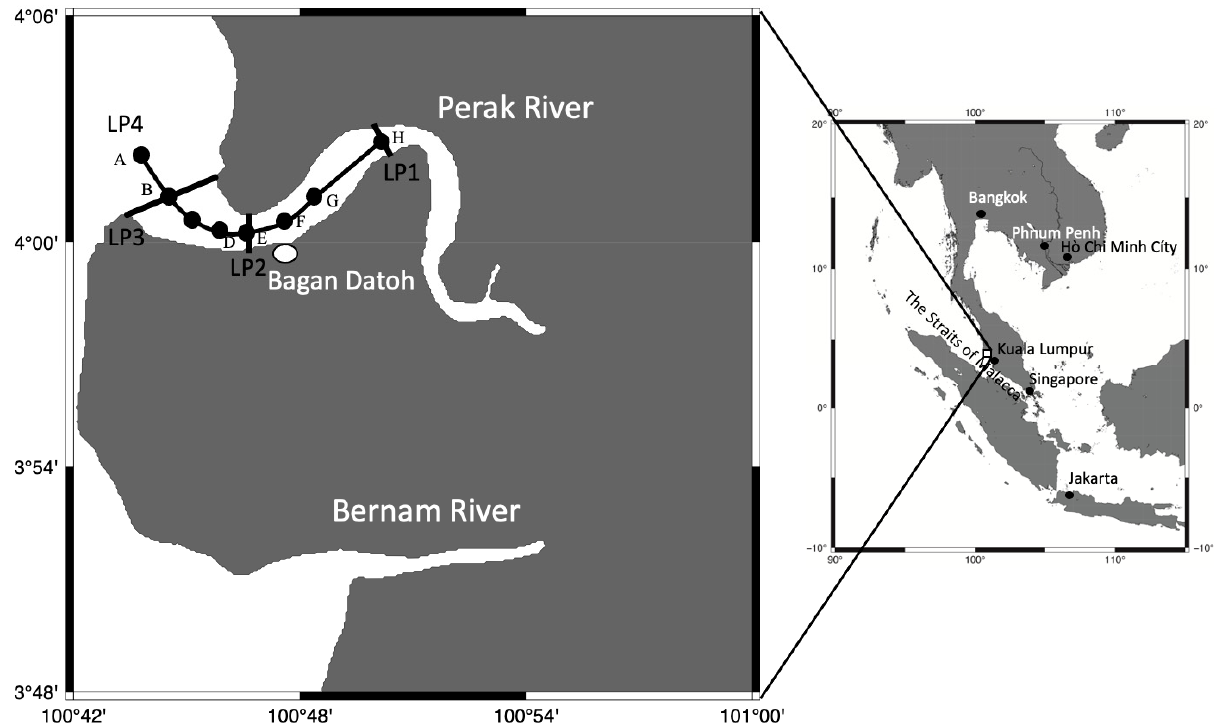
Figure 1. Map of the sampling sites of Perak River in Bagan Datoh, Perak, Malaysia. Black points labelled A–H show CTD casting points. Map was created using GMT 6.0 [17].